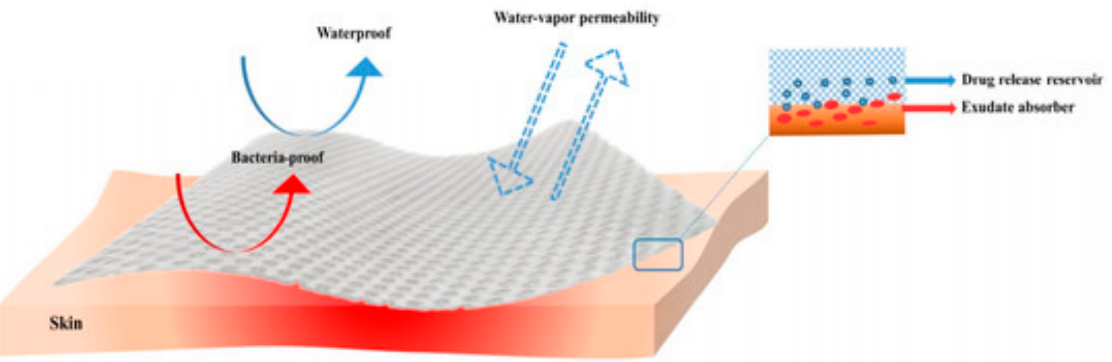
Figure 4. Properties of an ideal wound dressing. An optimal dressing is thus capable of preserving high humidity levels at the wound site while also eliminating excess exudates; in addition, it must be non-toxic, nonallergenic, comfortable, and cost-efficient, allow for oxygen and water vapour exchange, and protect against microbial invasion [25]. Reprinted from an open-access source.